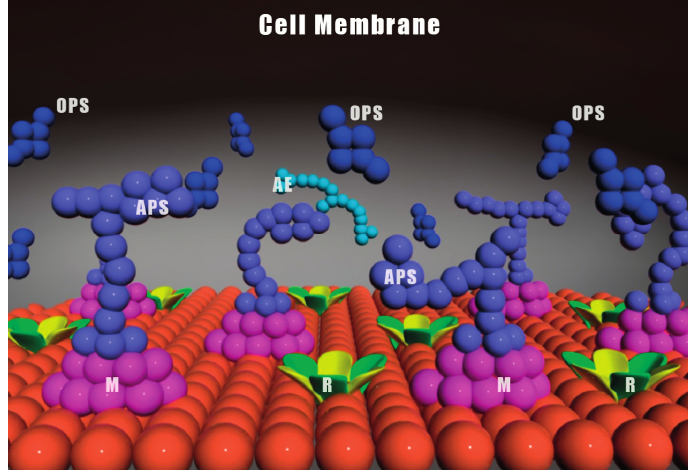
Figure 1. Hypothesis of how foodborne or metabolized polysaccharides/oligosaccharides interact with the cell outer membrane. OPS : (dropped) off polysaccharides; APS : attached polysaccharides; AE : antenna extracellular membrane polysaccharides that may absorb different wavelengths of light, changing the conformation of membrane associated proteins; R : receptors; M : membrane